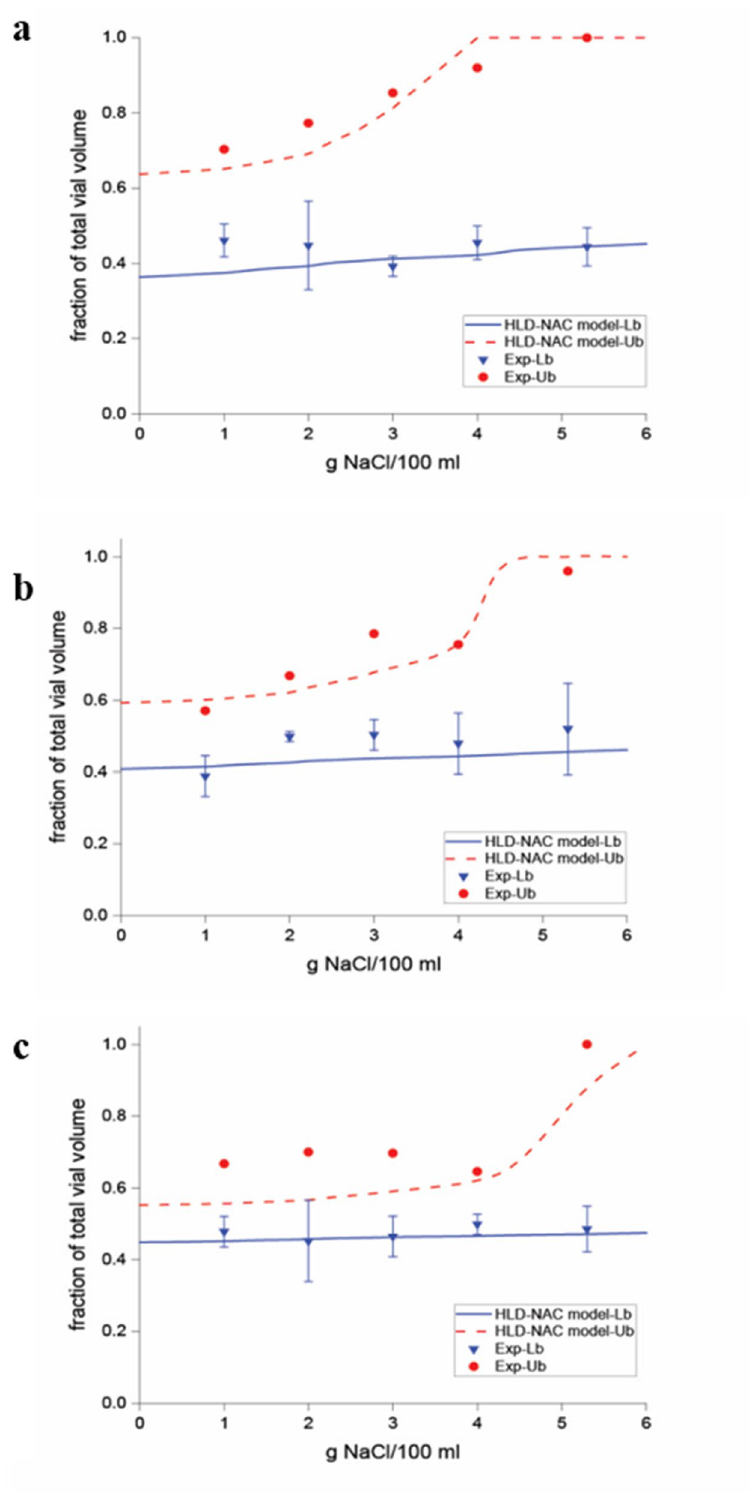
Figure 2. HLD-NAC volume fractions calculated with salinity scan (salinity between 1 and 5 g/100 mL at room temperature) for the synthetic microemulsion system ( S µ E ) formed with ( a ) Mixture (1) ( b ) Mixture (2), and ( c ) Mixture (3). After minimizing the objective function, which is described in the supplementary file, using the experimental fractional volumes (circles and triangles) and those predicted by the HLD-NAC model (solid and dashed lines), L = 140 and ξ =528 for Mixture (1), L = 68 and ξ =220 for Mixture (2), and L = 36 and ξ =104 for Mixture (3) were